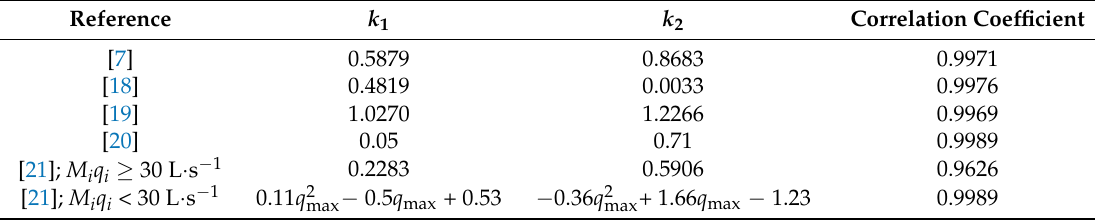
Table 2. Regression constants for approximating design flow rates.